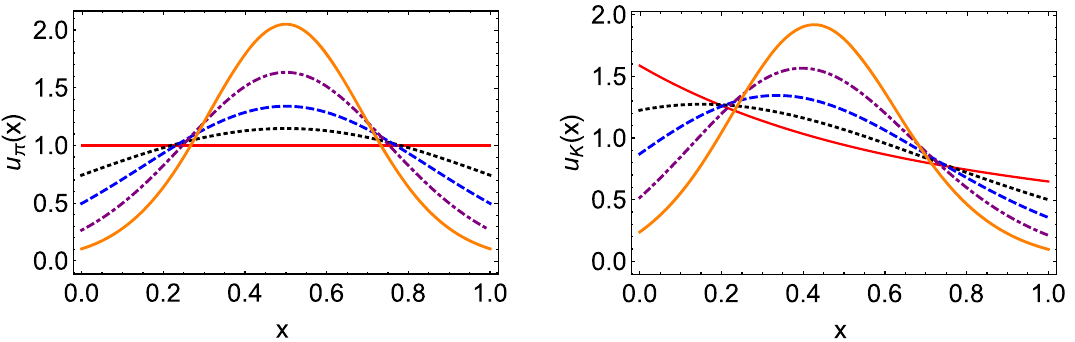
Fig. 10 Pion and kaon u quark PDF with different values of m π and m K : thin red line – m π ( m K ) = 0 GeV, black dotted line – m π ( m K ) = 0 . 4 GeV, blue dashed line – m π ( m K ) = 0 . 6 GeV, purple dotdashed line – m π ( m K ) = 0 . 8 GeV, thick orange line – m π ( m K ) = 1 . 0 GeV